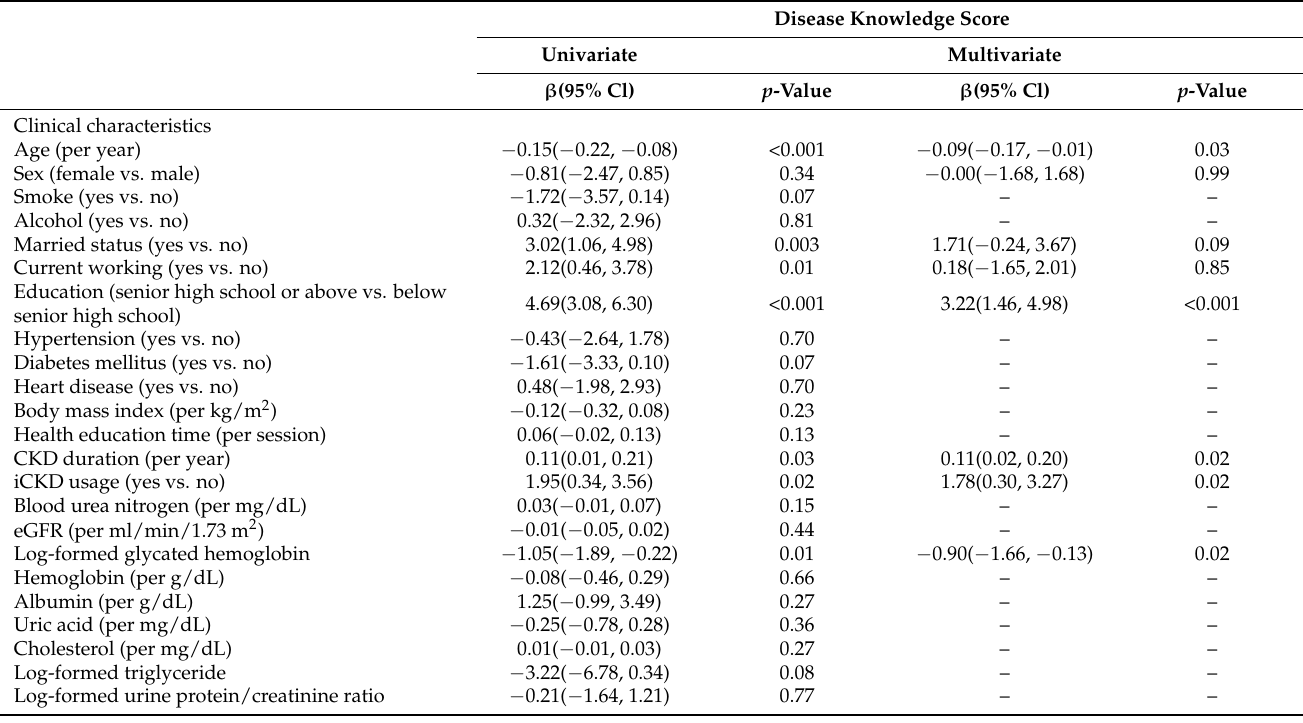
Table 3. The determinant of disease knowledge score in 214 CKD patients post propensity score